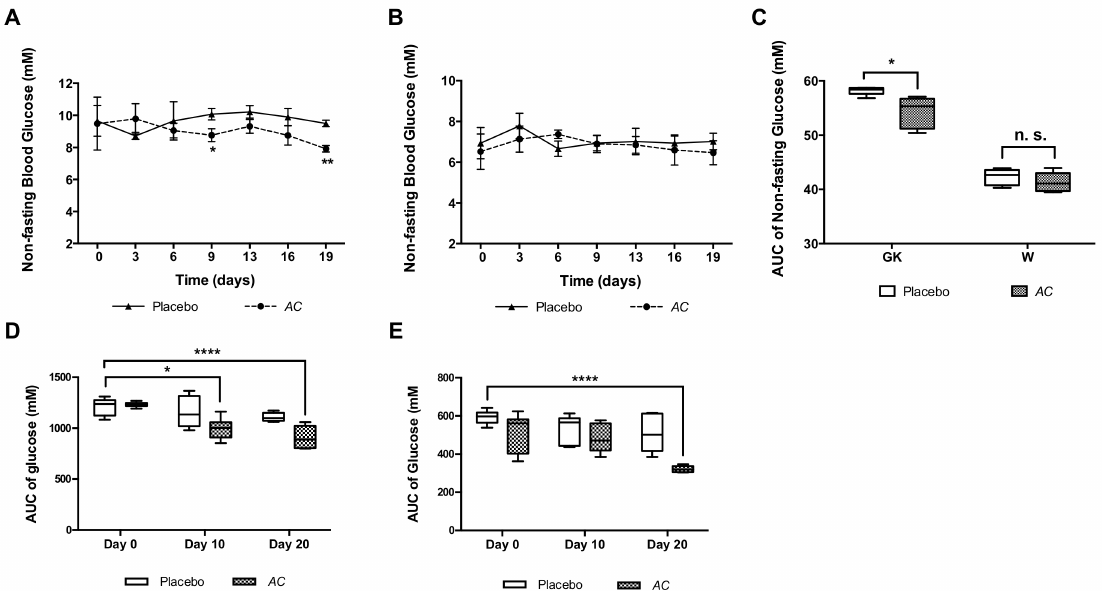
Figure 5. AC oral long-term treatment reduces the non-fasting glucose and improves glucose tolerance. The non-fasting glucose was determined every third day of treatment in GK ( A ) and W rats ( B ); the AUC of the non-fasting glucose were calculated from the interval 0–19 days ( C ); The AUC of glucose was calculated for each OGTT performed (day 0, 10 and 20) in GK ( D ) and W rats ( E ). Data are presented as means ± SEM ( n = 6). * p < 0.05, ** p < 0.01, **** p < 0.0001 when compared to